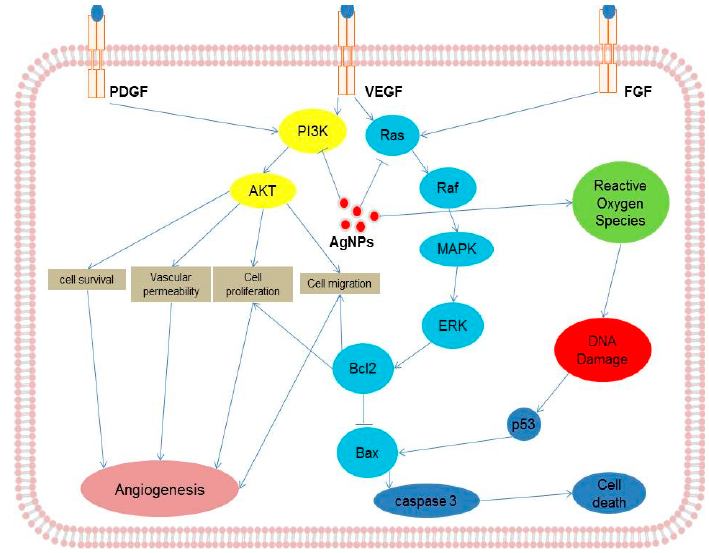
Figure 3. Possible signaling pathways of inhibition by silver nanoparticles on various angiogenic processes induced by growth factors in endothelial cells. PDGF, platelet-derived growth factor; VEGF, vascular endothelial growth factor; FGF, fibroblast growth factor; RAS, Ras is a membrane-associated guanine nucleotide-binding protein; RAF, RAF kinases are a family of three serine/threonine-specific protein kinases; MAPK, mitogen-activated protein kinases; ERK, extracellular-signal-regulated kinases; PI3K, phosphatidylinositide 3-kinases; AKT, also known as protein kinase B (PKB); Bcl-2, B-cell lymphoma 2; Bax, BCL2 associated X; p53, tumor suppressor p53.